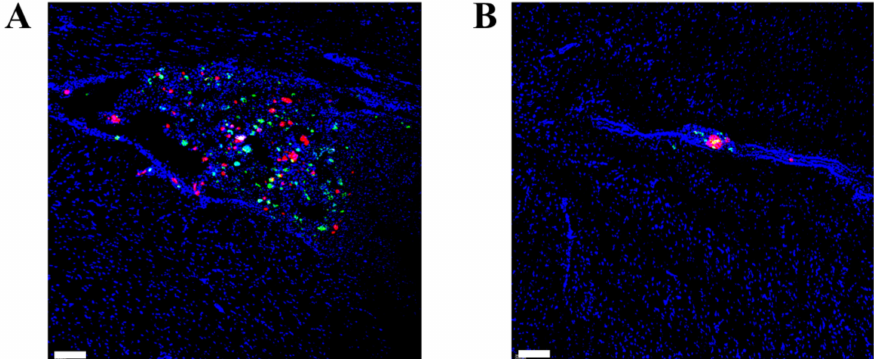
Figure 7. CLSM images of ( A ) glioma and ( B ) brain tissue at the injection site 2 days after contralateral injection of MSC-micelles to orthotopic C6 glioma-bearing rats. Oregon Green 488 conjugated PTX (green) was entrapped in HA-PLGA micelles, and MSCs were labeled by CM-Dil (red). The dual- labeled MSC-micelles were fabricated to track the distribution of both MSCs and PTX, simultaneously. Nuclei were stained with DAPI (blue) (bar = 100 µ